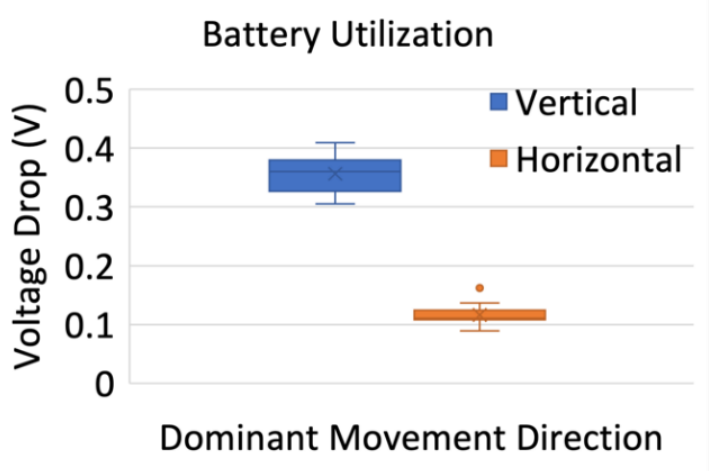
Figure 8. Boxplot of battery utilization with respect to direction.